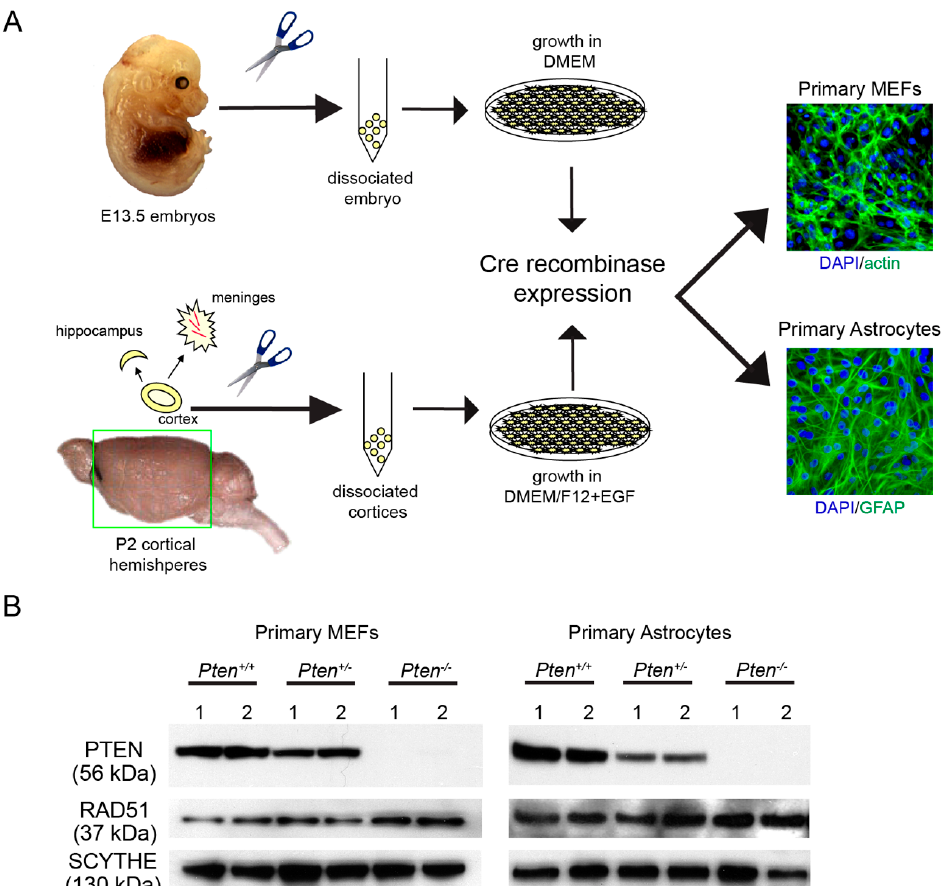
Figure 1. Establishing Pten-deficient primary mouse cells for Rad51 protein analysis. ( A ) Schematic of